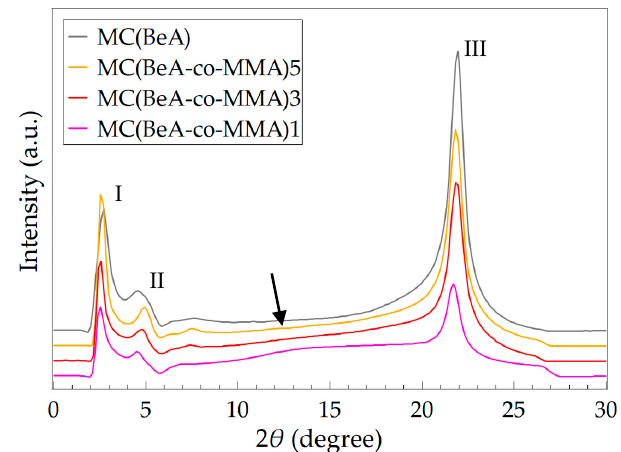
Figure 3. SAXS patterns of MC(BeA- co -MMA) microcapsules and MC(BeA) measured at room temperature. Three diffraction peaks were shown for both MC(BeA) and MC(BeA- co -MMA). Table 3. The locations of diffraction peaks and corresponding interplanar crystal spacing d of MC(BeA- co -MMA) microcapsules and MC(BeA) calculated from the SAXS results. Sample Peak I (2 θ )